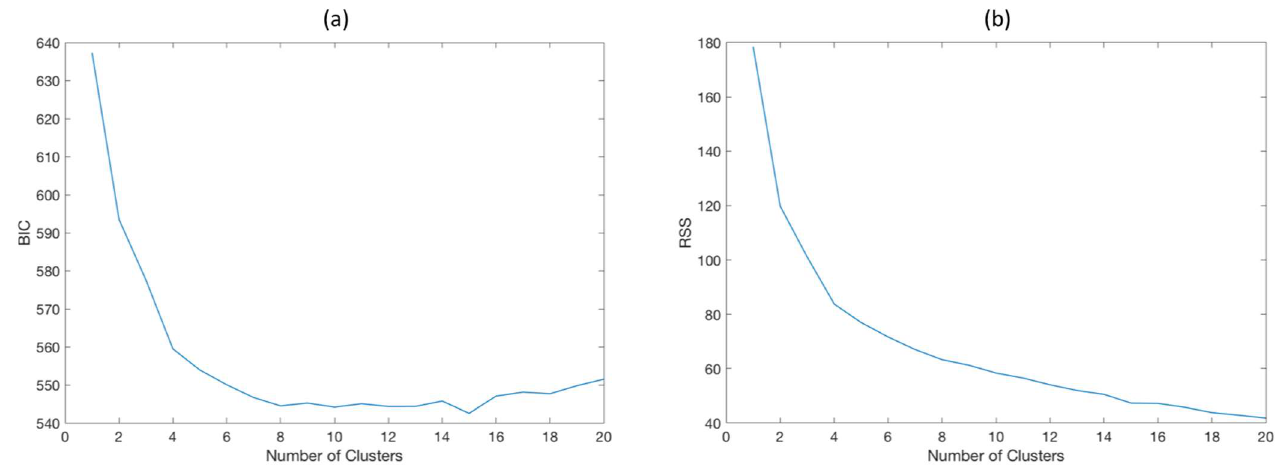
Figure 5. Tests to determine the optimal number of clusters for the k-means method. ( a ) The Bayesian Information Criterion (BIC) test shows that 8 is the optimal number of clusters at which the testing criterion is minimal, and; ( b ) The Elbow method test: it shows the Residual Sum of Squares error (RSS) as a function of the number of clusters.